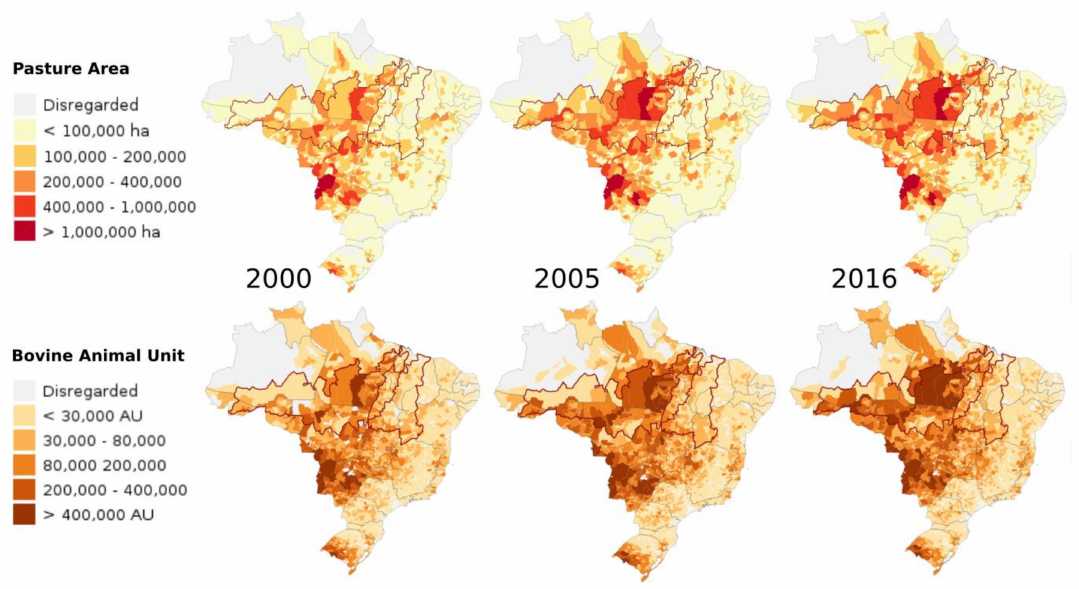
Figure 6. Geographic distribution of the mapped pasture and bovine animal unit, at the municipal basis, depicting the increase of both until the year 2005 and a subsequent intensification process, with stabilization of the pasture area and an increase in the number of